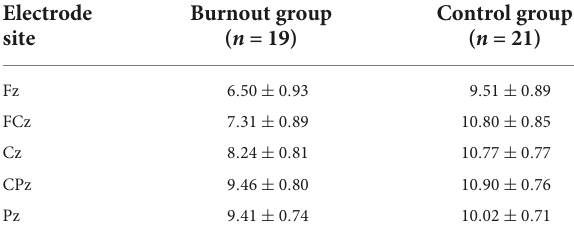
TABLE 4 Description of the average P3a amplitudes in the burnout group and control group ( ¯ x ± SE, µ